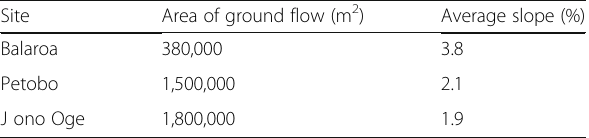
Table 1 Areas and average slope before the earthquake of each site of large ground flow